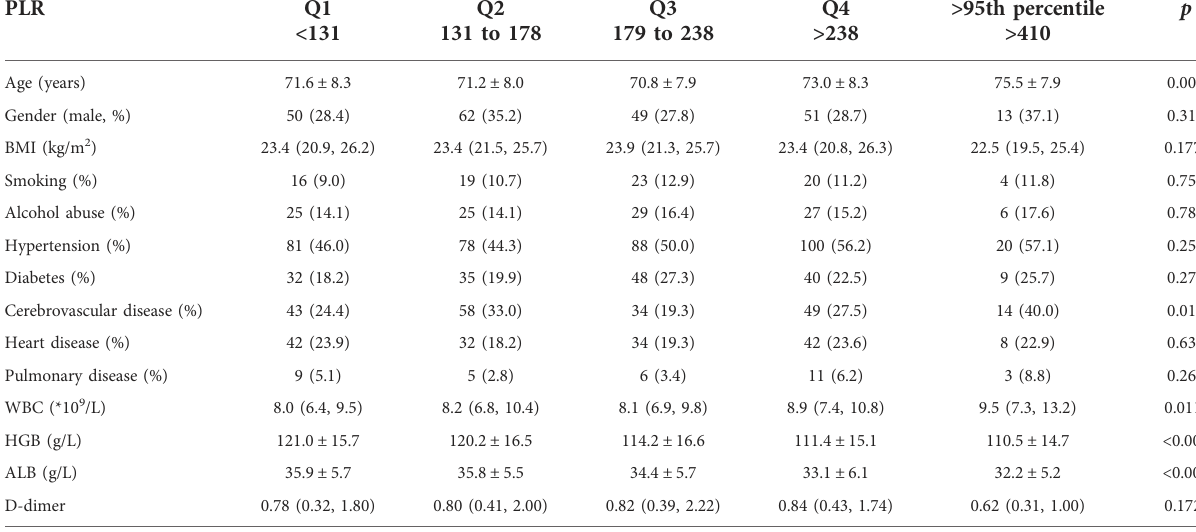
TABLE 2 Comparisons of baseline characteristics of included patients across fi ve subgroups of PLR. PLR Q1 Q2